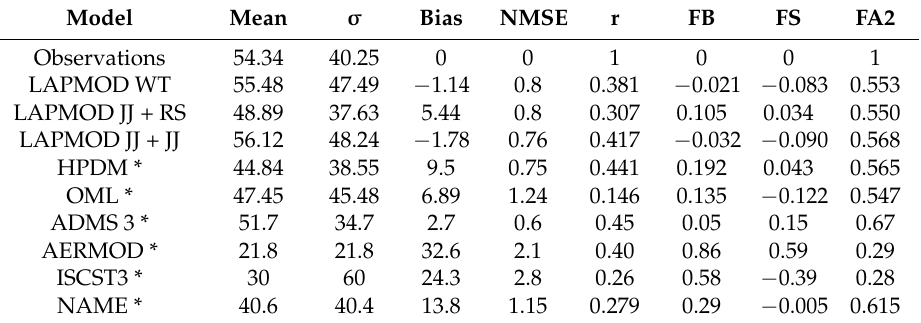
Table 4. Performance statistics of some dispersion models for the Kincaid SF 6 observations of best quality.